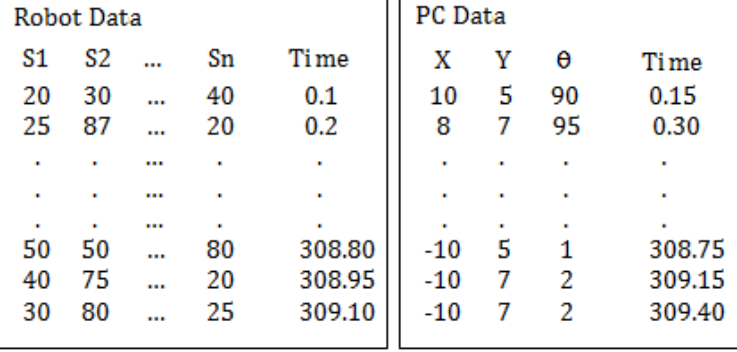
Figure 9. Data stored in the robot and in the